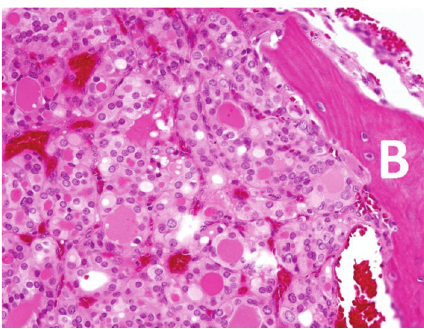
Figure 2: Histopathological examination of the resected left femur showing a follicular pattern of papillary thyroid carcinoma (H&E stain). A bone spicule (b) is noted on the right